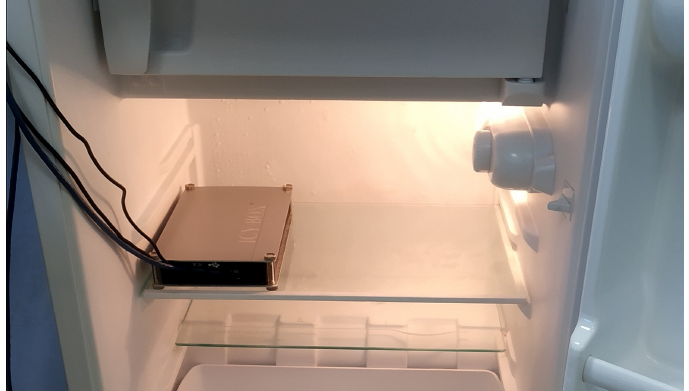
Figure 6: Picture of one of the four boards encapsulated in a metal case inside an ordinary household refrigerator. Three cables coming out of the case are USB, Ethernet, and